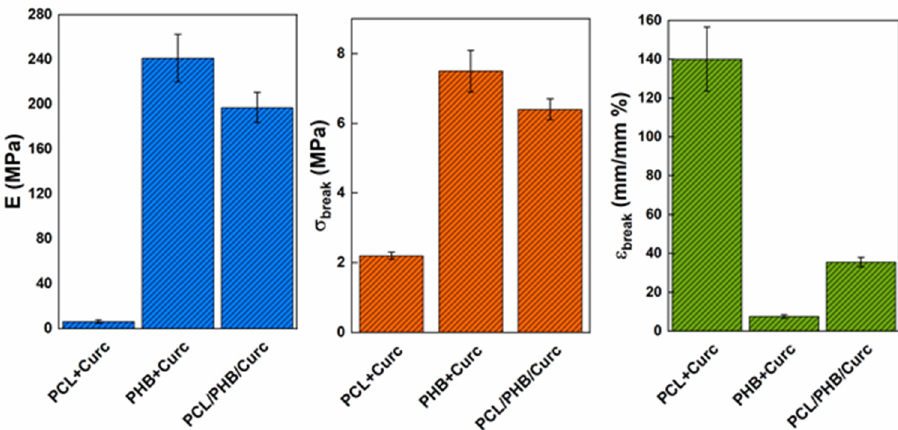
Figure 7. Elastic modulus, E (MPa), stress at break point, σ b (MPa), and elongation at break point, ε b (mm/mm%), for the electrospun membranes loaded with curcumin.